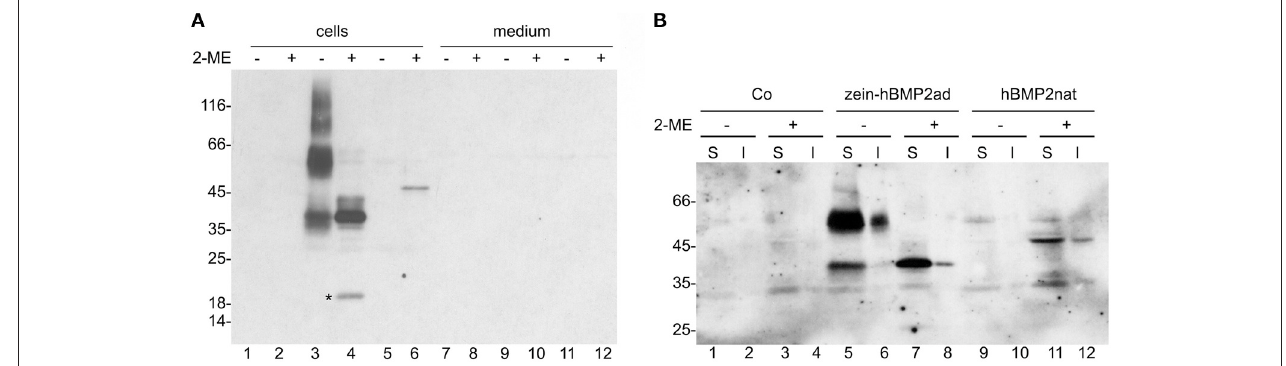
FIGURE 2 | hBMP2nat and zein-hBMP2ad are soluble in transiently transfected protoplasts and are not secreted. (A,B) Tobacco leaf protoplasts were transiently transfected with plasmid encoding hBMP2nat (lanes 5–6, 11–12), zein-hBMP2ad (lanes 3–4, 9–10), or empty plasmid lanes (1–2, 7–8) and incubated for 24h. (A) Protoplasts or incubation media were homogenized in the presence ( + ) or absence ( − ) of 2-ME. Aliquots corresponding to 20.000 protoplasts (cells) or the corresponding incubation medium (medium) were analyzed by SDS-PAGE in reducing conditions, followed by protein blot with anti-Flag antiserum. (B) Aliquots corresponding to 16.500 protoplasts were homogenized in the presence ( + ) or absence ( − ) of 2-ME. After centrifugation, soluble (S) material and insoluble precipitate (I) were analyzed by SDS-PAGE in reducing conditions, followed by protein blot with anti-Flag antiserum. Asterisk: 18kD fragment of hBMP2ad. Numbers on the left indicate the positions of molecular mass markers, in kD.